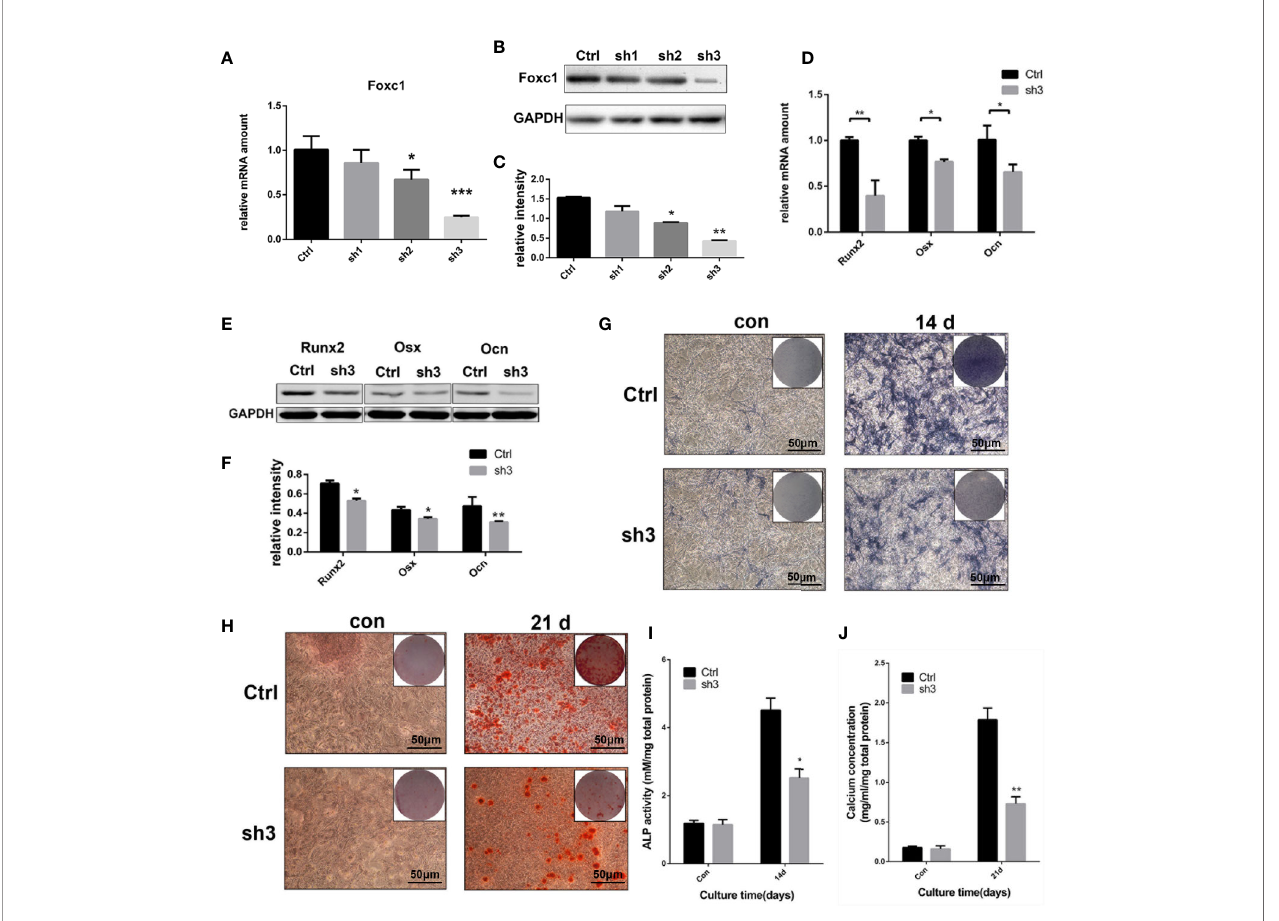
FIGURE 3 | Foxc1 knockdown inhibited osteogenic differentiation induced by intermittent PTH treatment in vitro . (A) mRNA expression level of Foxc1 in Lv- scramble, Lv-shFoxc1 – 1, Lv-shFoxc1 – 2, and Lv-shFoxc1 – 3 MC3T3-E1 cells at 48 h after transfection. (B, C) Protein expression level and quantitative analysis of Foxc1 at 48 h after transfection. (D) mRNA expression levels of the osteogenic markers, Runx2, Osx, and Ocn on the 1st day, 4th day, and 7th day after exposed to intermittent PTH treatment in Lv-scramble and Lv-shFoxc1 – 3 MC3T3-E1 cells. (E, F) Protein expression level and quantitative analysis of the osteogenic markers, Runx2, Osx, and Ocn on the 1st day, 4th day, and 7th day after exposed to intermittent PTH treatment in Lv-scramble and Lv-shFoxc1 – 3 MC3T3-E1 cells. (G, I) ALP staining and activity in Lv-scramble and Lv-shFoxc1 – 3 MC3T3-E1 cells after 2 weeks of intermittent PTH treatment. (H, J) Alizarin red S staining and calcium concentration in Lv-scramble and Lv-shFoxc1 – 3 MC3T3-E1 cells after 3 weeks of intermittent PTH treatment. Scale bar = 50 m m. * p < 0.05, ** p < 0.01, *** p <